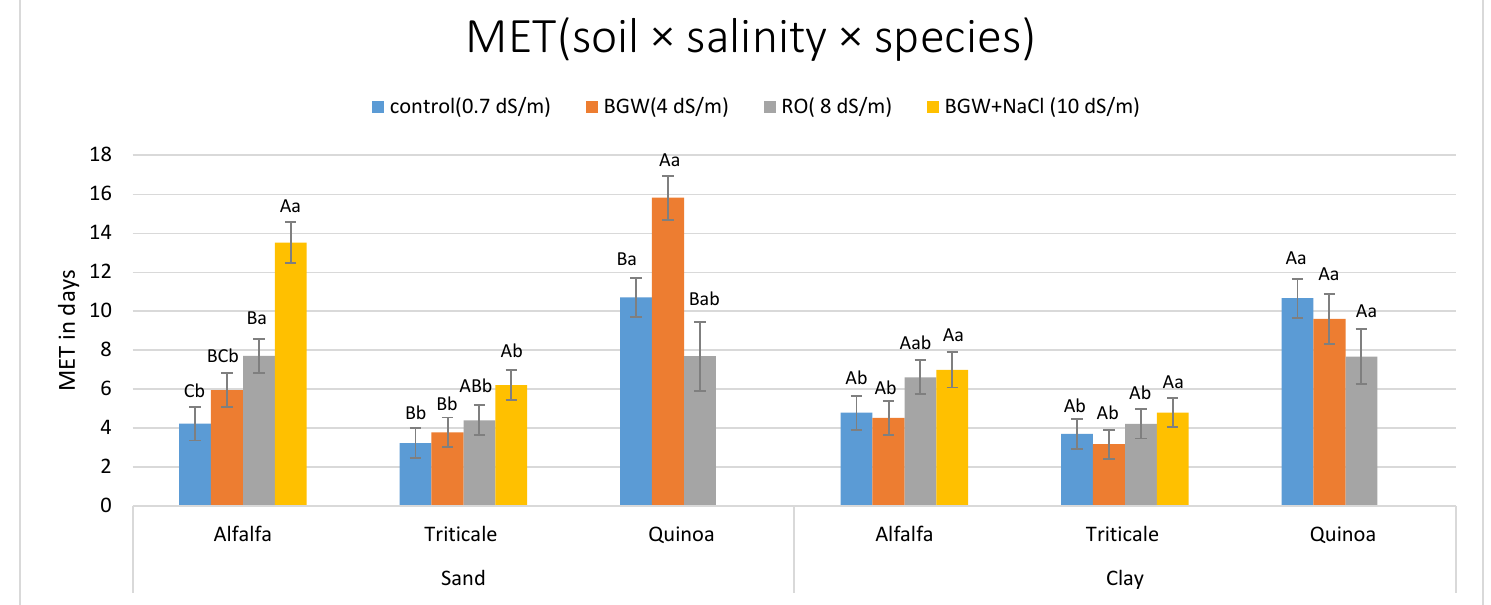
Figure 4. Mean emergence time (MET) (days) of alfalfa, triticale, and quinoa. MET in days for alfalfa, triticale, and quinoa with soils × salinity × species interaction at four di ff erent salinity levels. A, B, C letters correspond to significant di ff erences in the MET within the species at di ff erent salinity levels and a, b letters correspond to statistically significant di ff erences in the MET between the species at α ≤ 0.05. Results are the mean ± SEs (standard errors).